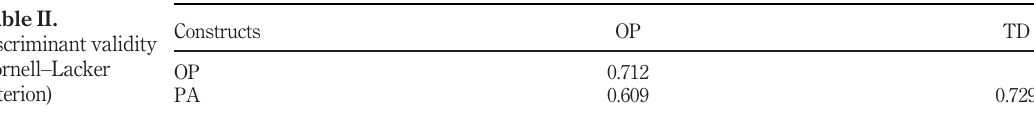
Table I. Factor loading, composite reliability and convergent validity analysis